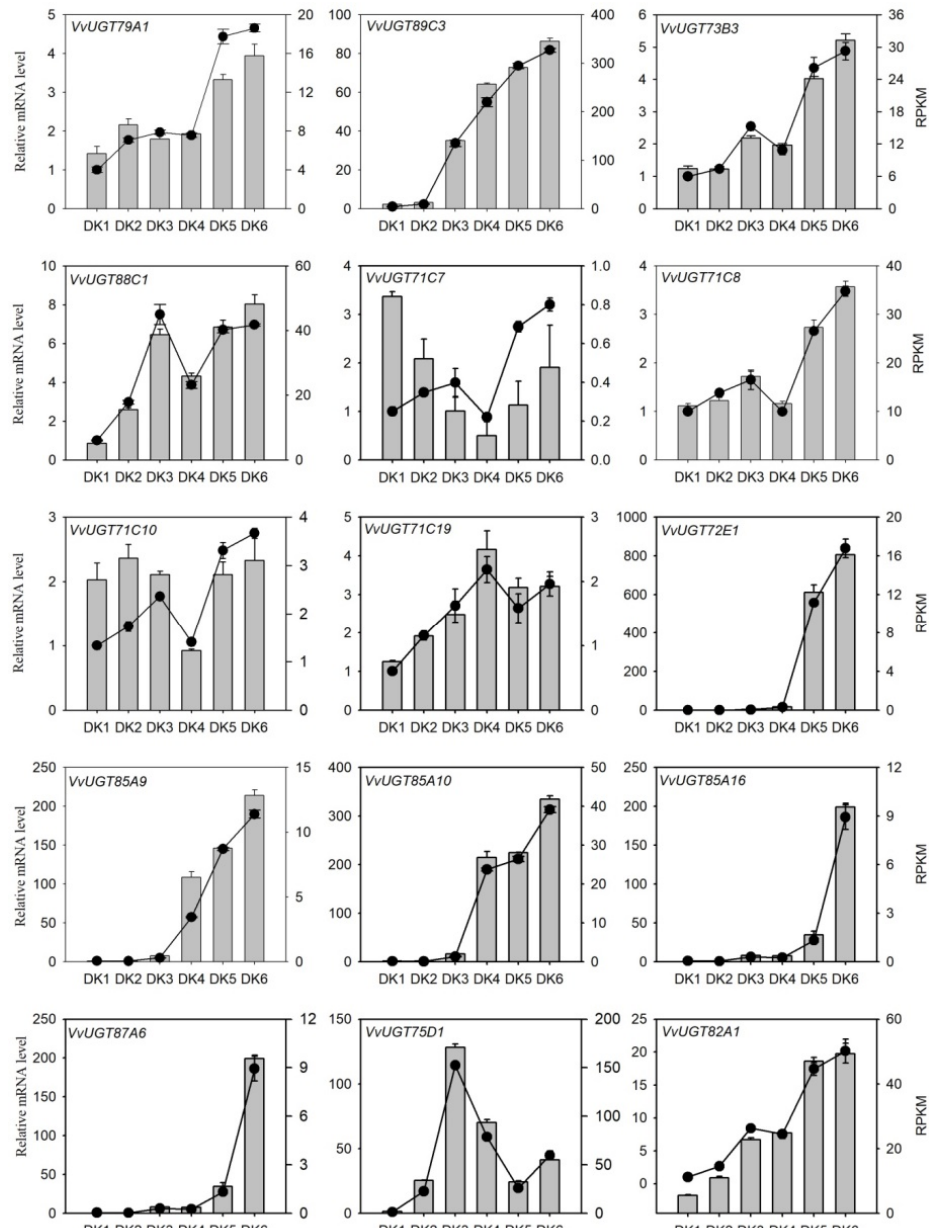
Figure 8. Analysis of gene expression characteristics of UGT members at different development stages of grapes. DK1~6 represented the developmental stages of grape fruit, 45 DAA (Days after anthesis), 60 DAA, 75 DAA, 90 DAA, 105 DAA and 120 DAA, respectively.